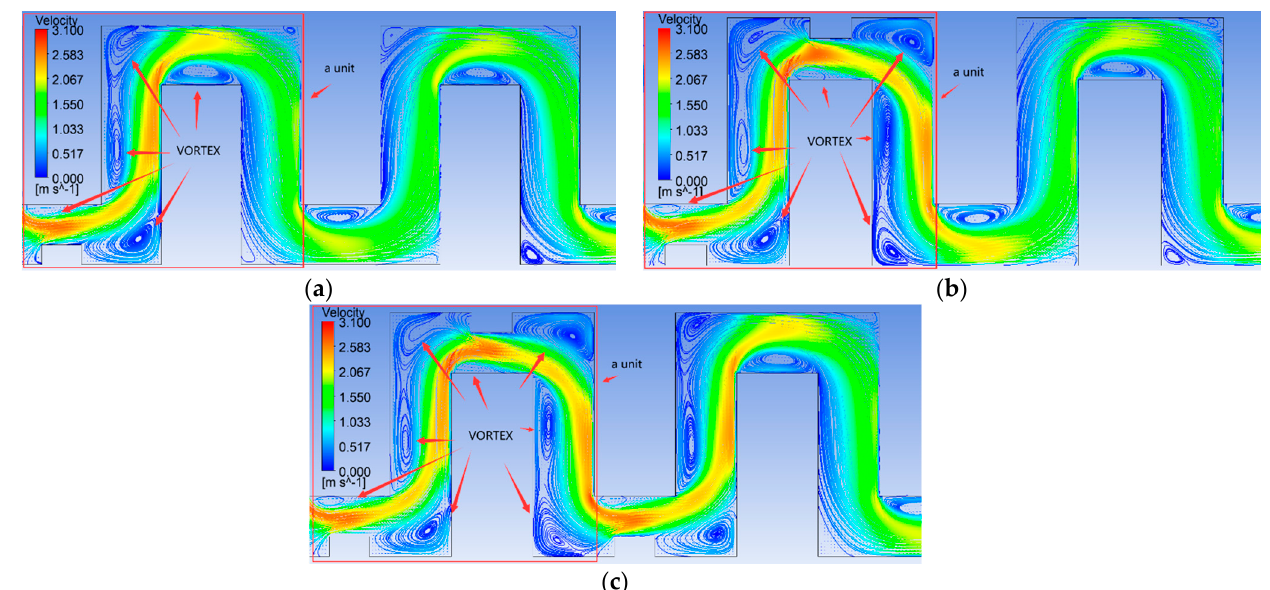
Figure 7. Streamlined diagram of the D emitter.